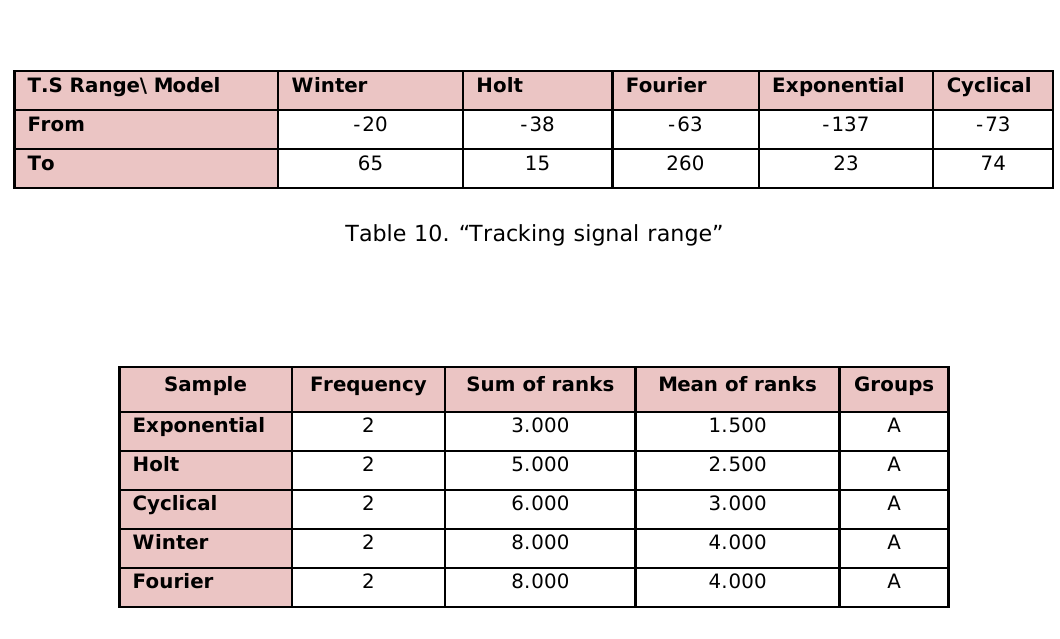
Table 11. “Multiple pair wise comparisons for tracking signal range using the Nemenyi’s